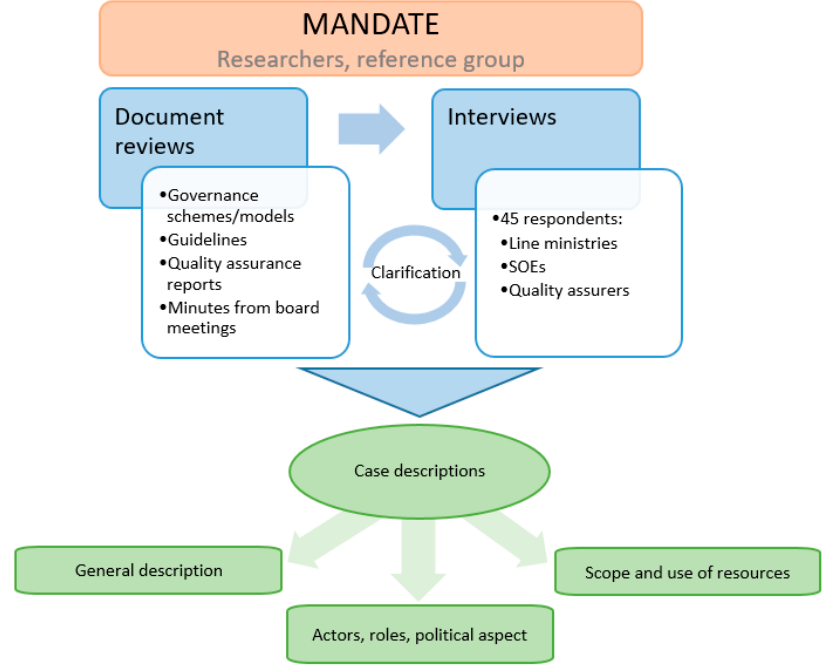
Figure 2. Research steps.